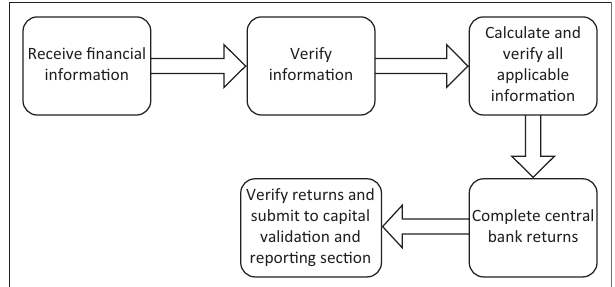
FIG URE 13: Workflow of the regulatory capital management.